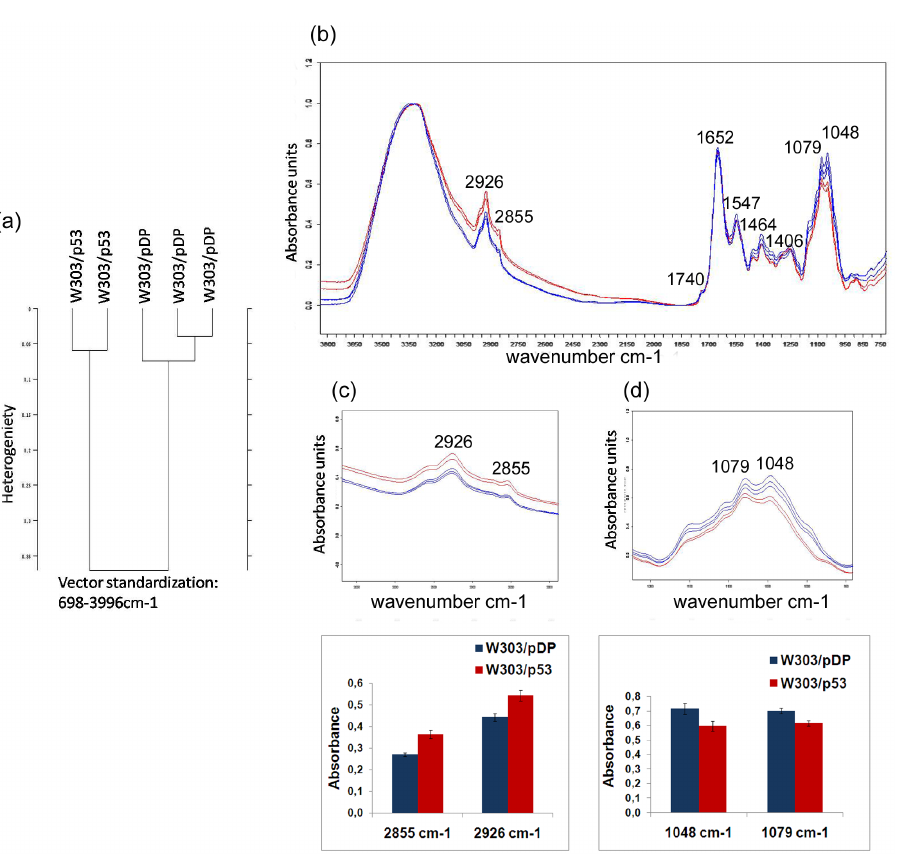
Fig 2. FTIR spectroscopy analysis of the whole recombinant yeast clones W303/pDP and W303/p53. (a) Dendrogramrepresentinghierarchical cluster analysisof W303/pDP and W303/p53 FTIR spectra. (b) FTIR spectra of W303/pDP (blue line) and W303/p53 (red line) grown on MMGAL, (c) spectral intensity band changesin 3000–2820cm − 1 regioncorrespondingto membranechangesand spectral intensity band changes in 1187-945cm -1 regionshowingDNA changes(d); the values are means of three independentexperiments.